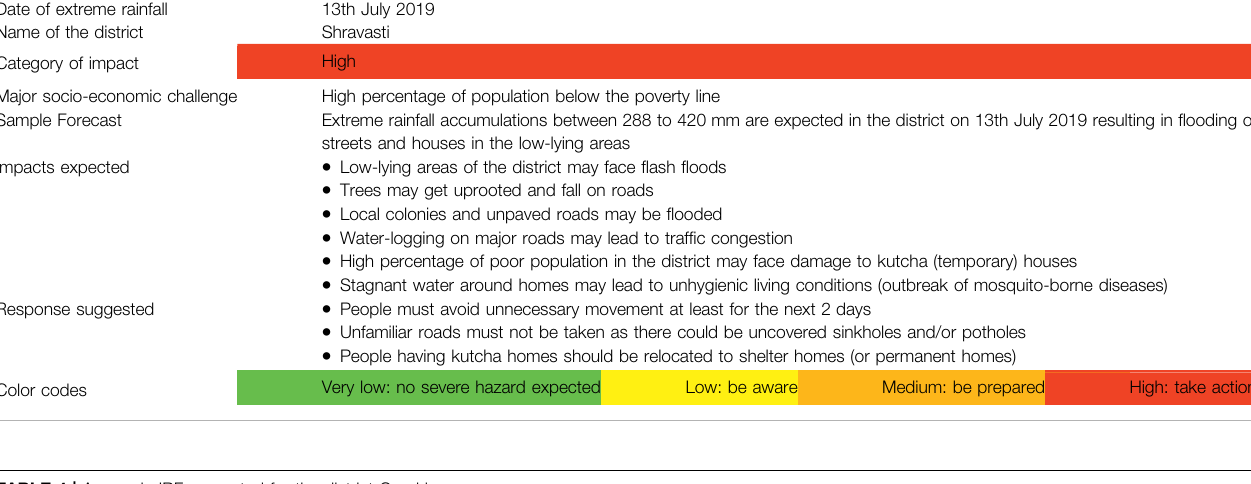
TABLE 3 | A sample IBF generated for the district Shravasti.